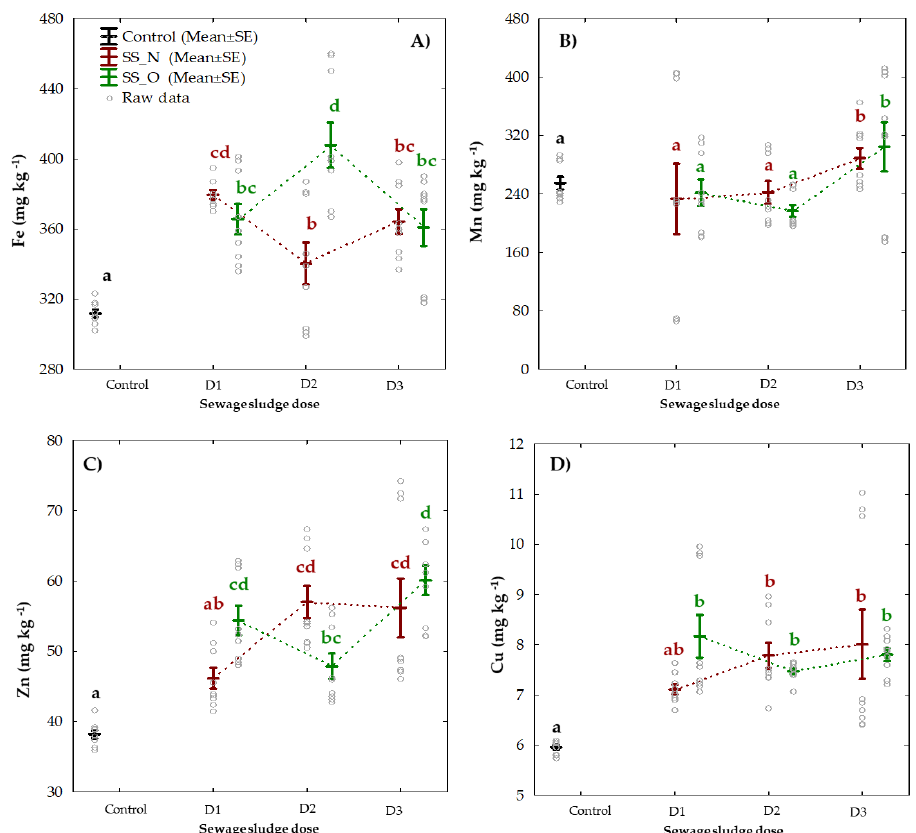
Figure 4. ( A – D ). Content of micronutrients (Fe, Mn, Zn, Cu) in the aboveground biomass of maize depending on the type and dose of sewage sludge (mean values from experiment series). Mean values (n = 9) ± standard error. Identical superscripts denote no significant ( p > 0.05) differences between the experimental variants according to the post hoc Tukey HSD test. Explanation: SS_N—non-ozonated sewage sludge; SS_O—ozonated sewage sludge; D1, D2, D3—dose of sewage sludge—3, 6, 9 Mg ha − 1 , respectively.